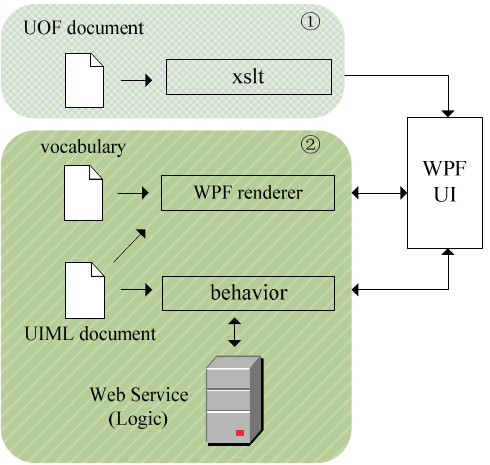
Figure 5. Processing flow of the intelligent document